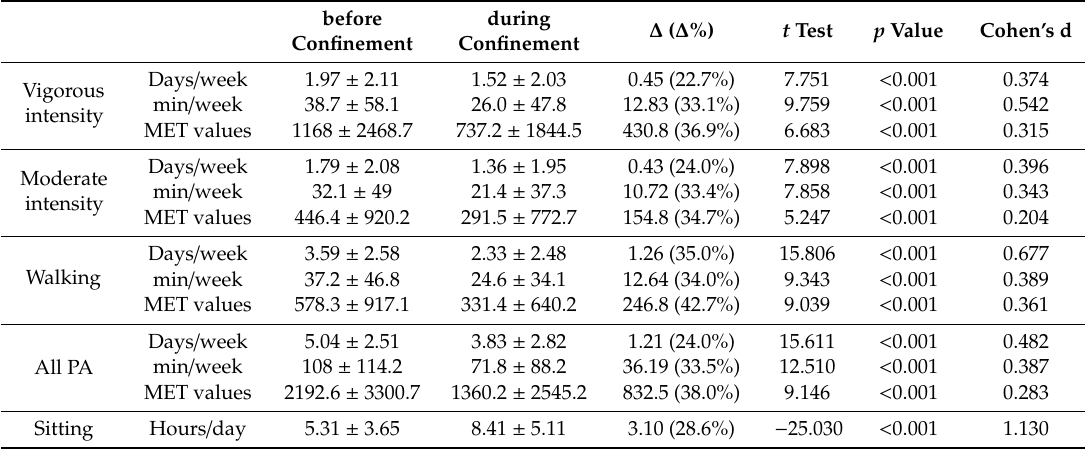
Table 2. Responses to the physical activity questionnaire recorded before and during home